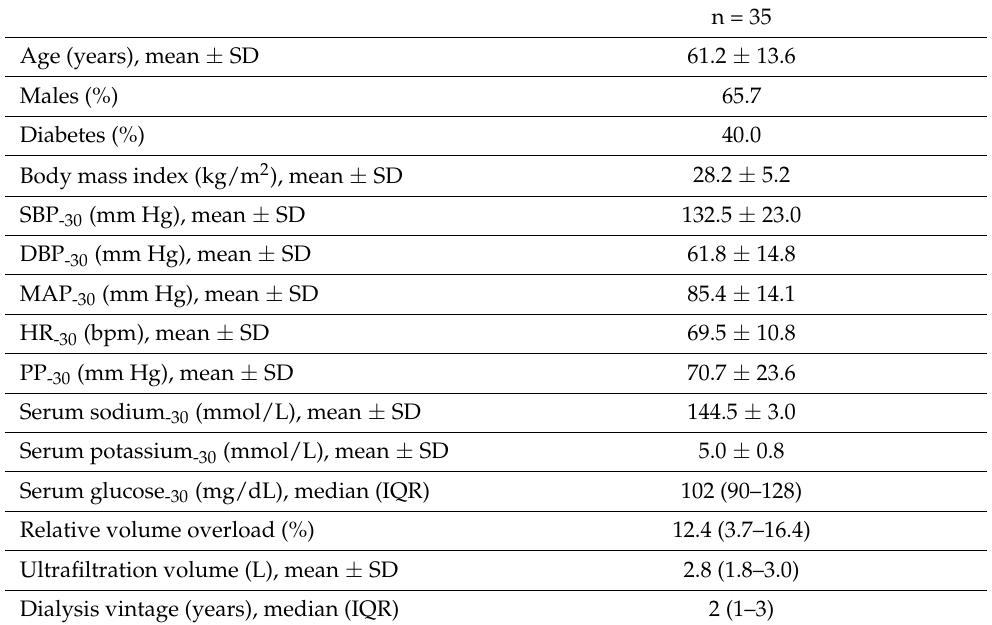
Table 1. Clinical and dialysis characteristics of the studied sample.